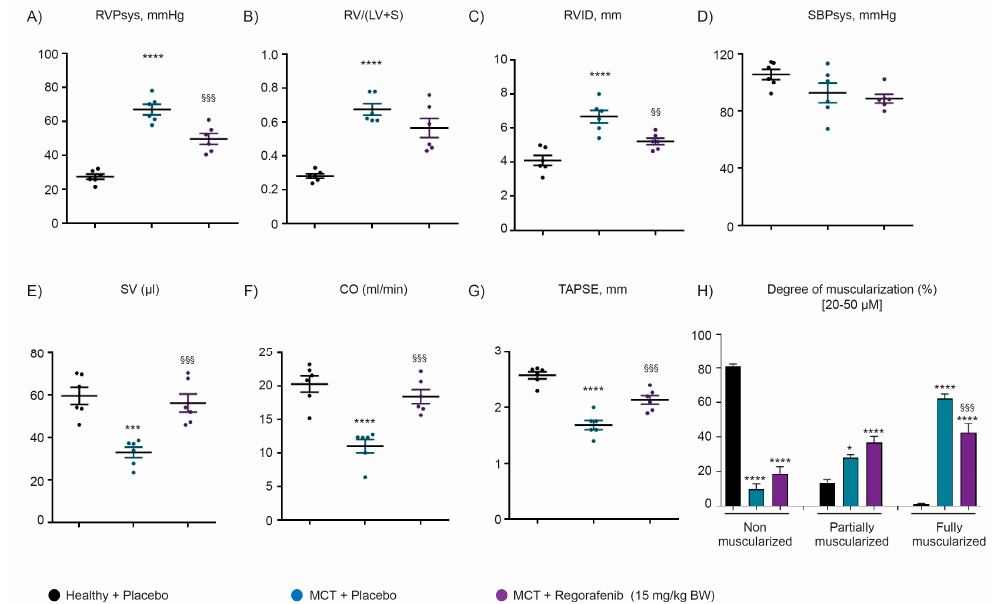
Figure 4. Effect of regorafenib on cardio-pulmonary functions in monocrotaline (MCT)-induced pulmonary hypertension. ( A ) Right ventricular systolic pressure (RVSP, mmHg). ( B ) Fulton index measured as the ratio of RV to LV plus septum (RV/LV + S). ( C ) Right ventricle internal diameter (RVID, mm). ( D ) Systemic arterial pressure (SBPsys, mmHg). ( E ) Stroke volume (SV, µL). ( F ) Cardiac output (CO, mL/min) ( G ) Tricuspid annular plane systolic excursion (TAPSE, mm), and ( H ) Degree of muscularization was measured as a percentage of small pulmonary arteries (20–50 µM) characterized by non-muscularized, partially muscularized, and fully muscularized in healthy + placebo ( n = 6), MCT + placebo ( n = 4–6) and MCT rats treated with regorafenib ( n = 6). **** p < 0.0001, *** p < 0.001, and * p < 0.05 versus healthy + placebo; §§§ p < 0.0001, and §§ p < 0.01 versus MCT + placebo. Data represent the mean ± SEM.